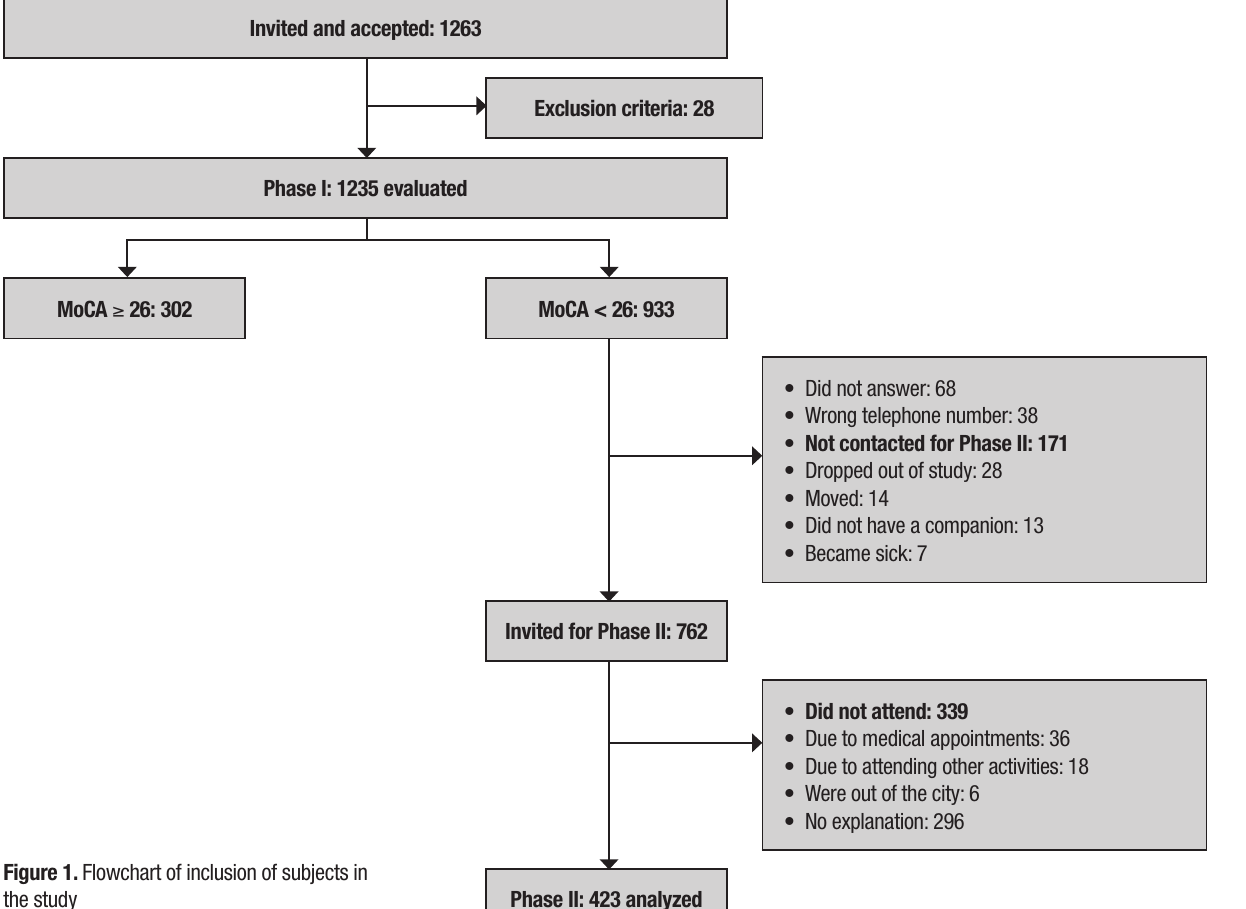
analyzedFigure 1. Flowchart of inclusion of subjects in the